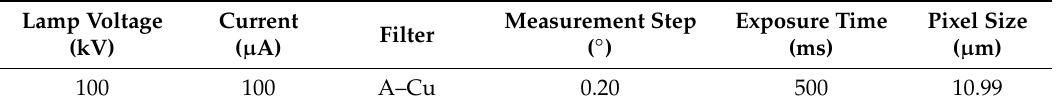
Table 2. Scanning parameters for the ceramic casting mould